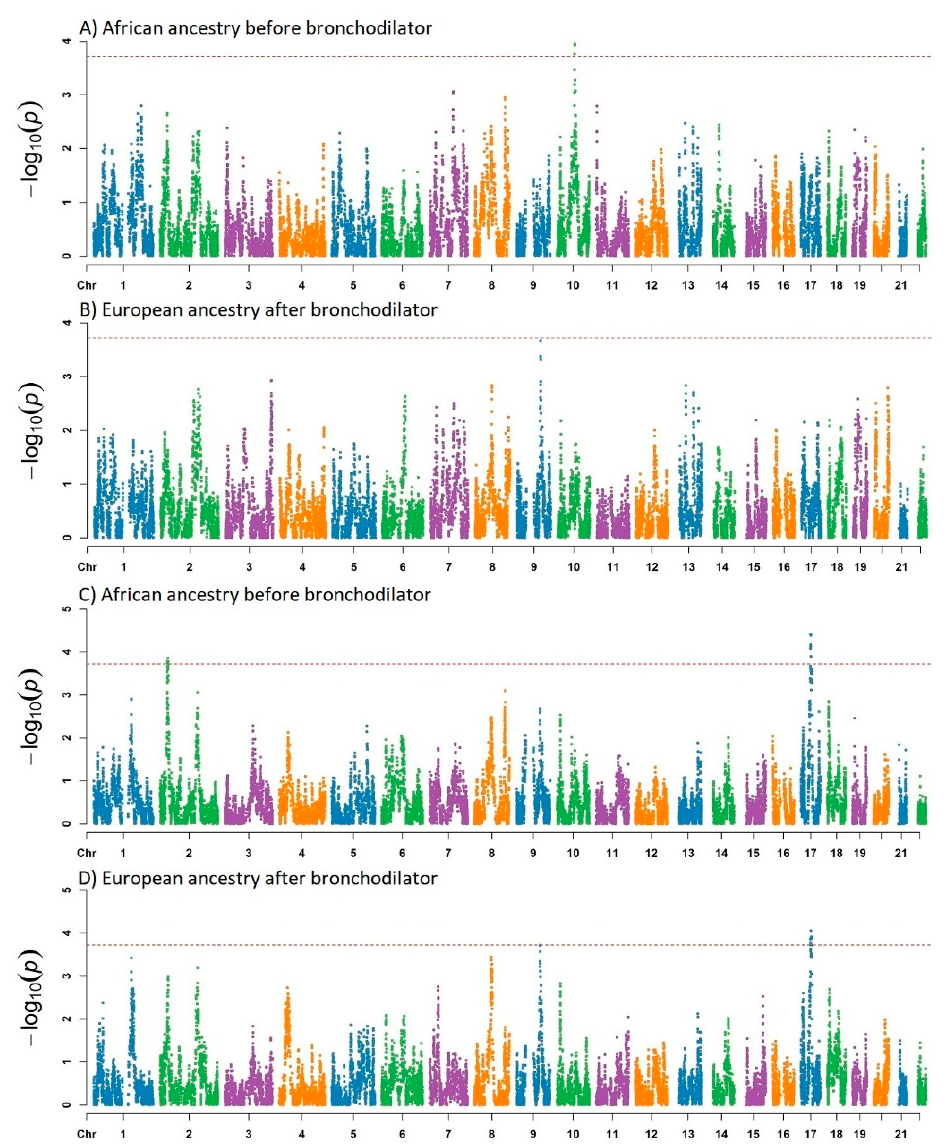
Figure 1. Manhattan plot of the admixture mapping (AM) for lung function for African and European ancestry in the SCAALA population ( n = 958 children). (Figure 1): Association testing for lung function FEV 1 /FVC ratio percentage and African ancestry ( A , C ) before and after the bronchodilator, respectively. African ancestry AM shows negative significant peaks in 10q22.1 ( A ) and negative in 17q21.31 and 2p23.1 ( C ). Testing for lung function FEV 1 / FVC and European ancestry ( B , D ) significant peaks in 17q21.31 and 2p23.1 ( C ). Testing for lung function FEV 1 /FVC and European ancestry ( B , D ) before and after the bronchodilator, respectively. European ancestry AM analysis shows a positive associated peak at 17q21.31 ( D ). Analysis of 17q21.31 and 2p23.1 regions were also